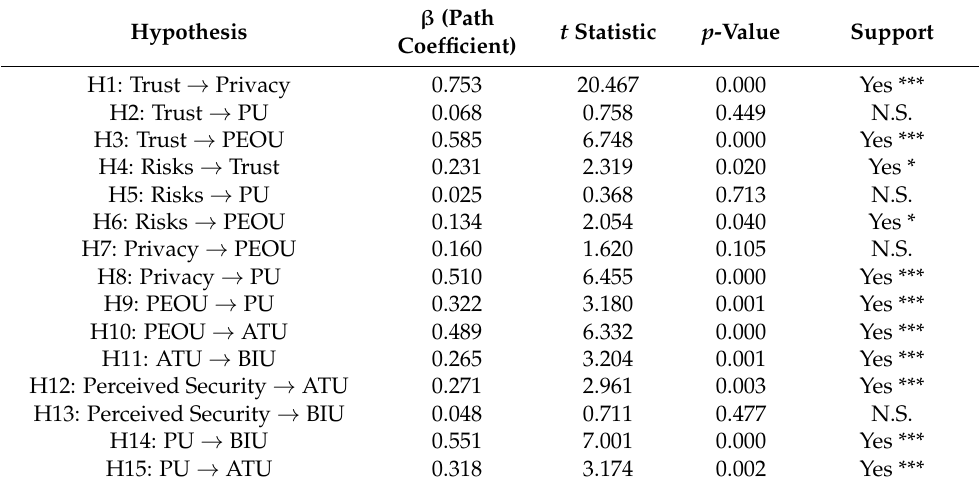
Table 5. Hypothesis results: path coefficients and statistical